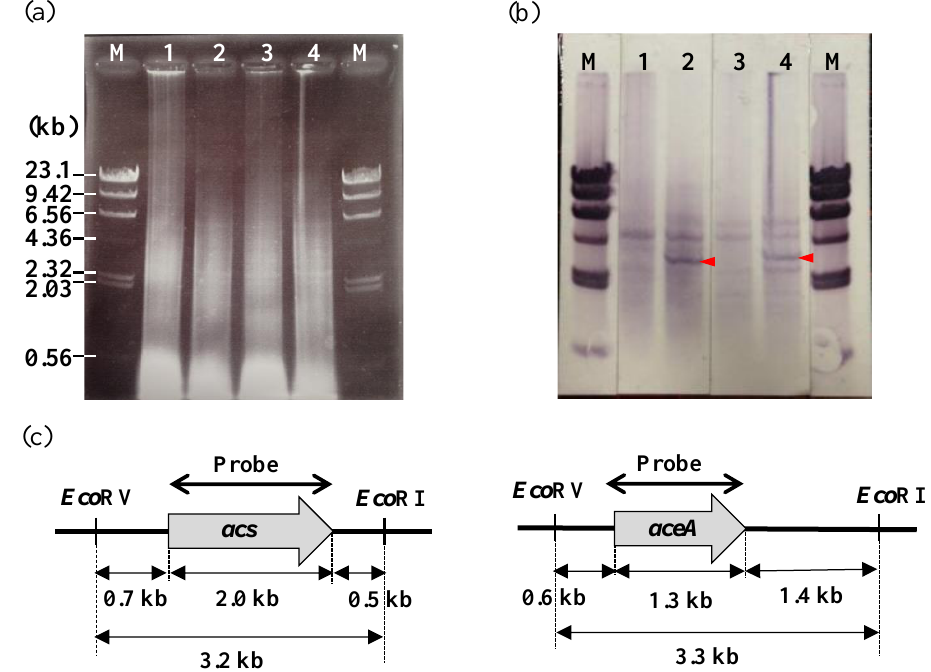
Figure 3. Electrophoresis of Eco RI- Eco RV-digested total DNA of C. freundii IFO 13545 and its gene-disrupted mutants, ∆ acs and ∆ aceA ( a ); corresponding Southern blots ( b ); and restriction maps of the regions around acs and aceA in the IFO 13545 genome ( c ). Lane M: λ DNA Hin dIII digest (size marker); Lane 1: ∆ acs ; Lanes 2 and 4: IFO 13545 (wild type); Lane 3: ∆ aceA . A probe based on the acs sequence was used in Lanes 1 and 2, whereas a different probe corresponding to the aceA sequence was used in Lanes 3 and 4. The arrow heads indicate the original gene fragments in the wild-type strain.